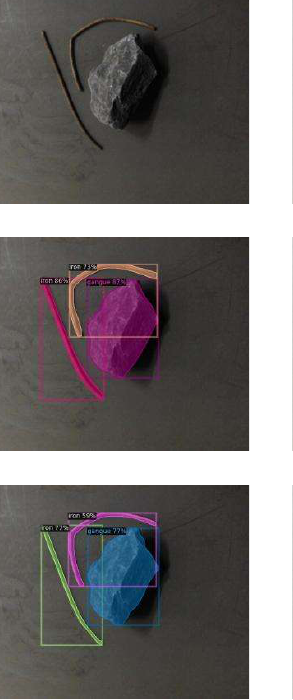
Figure 18. Comparison of detection effects before and after data augmentation. ( a ) Samples; ( b ) Be- fore augmentation; ( c ) After augmentation.